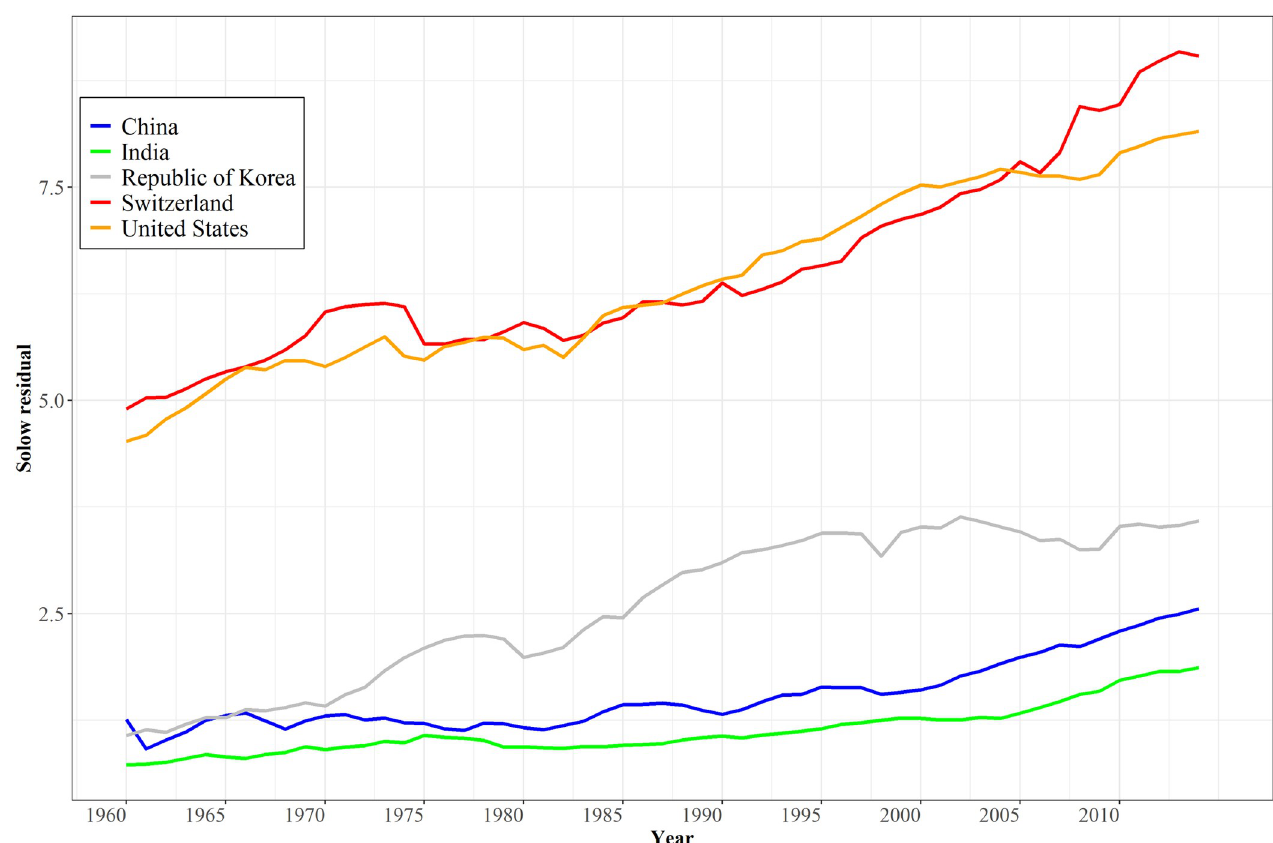
Fig 1. The stock of TFP (Solow residual) in selected countries. Note: The stock was computed by dividing GDP by the product of capital raised to the long- term average value of alpha (capital share of value added) and labor to 1 minus alpha. Source: IFs Version 7.61, using data from the Penn World Tables, release